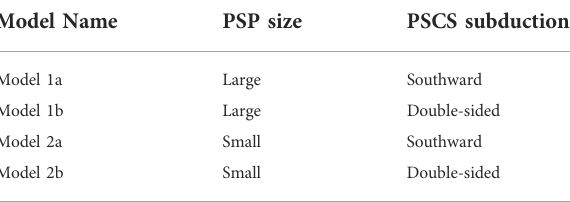
TABLE 1 Model naming scheme based on the implemented Cenozoic tectonic reconstruction following Lin et al. (2020).